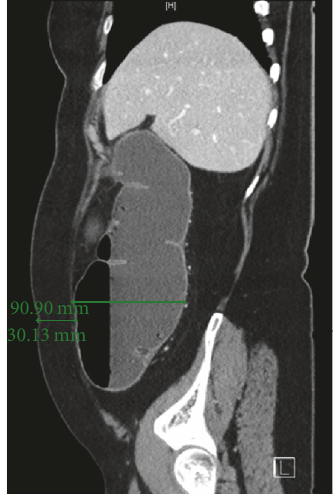
Figure 4: Sagittal CT showing caecum measured from the anterior abdominal